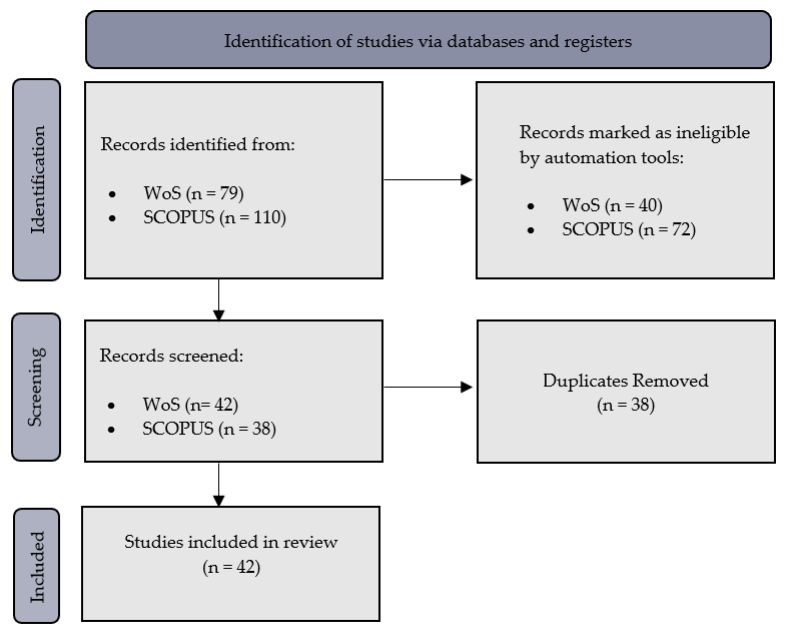
Figure 3. PRSIMA Flowchart for the SLR used in this study (adapted from: Page MJ, McKenzie JE, Bossuyt PM, Boutron I, Hoffmann TC, Mulrow CD, et al. [22])